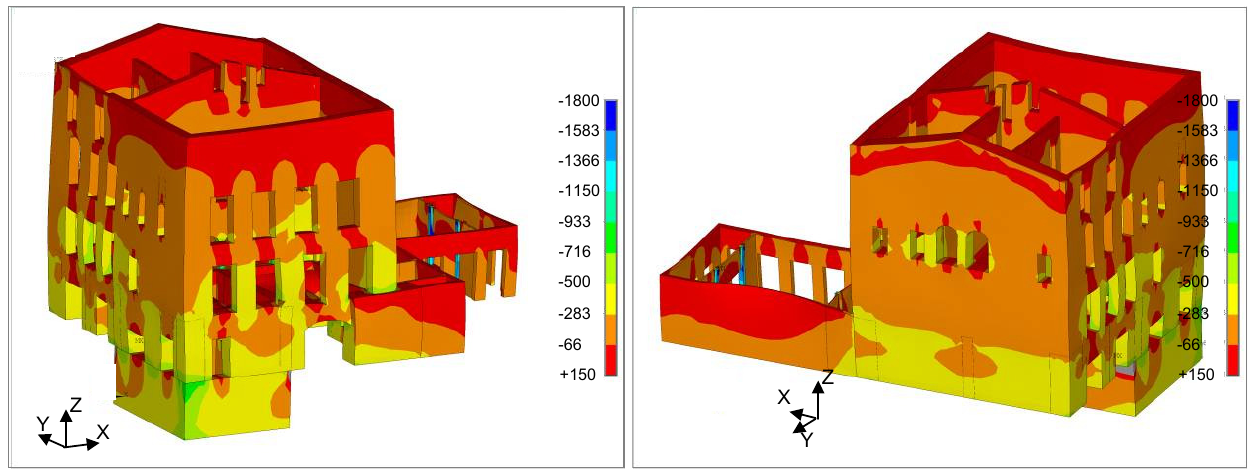
Figure 8. Static analysis: vertical compressive stresses (units are kN/m 2 ).